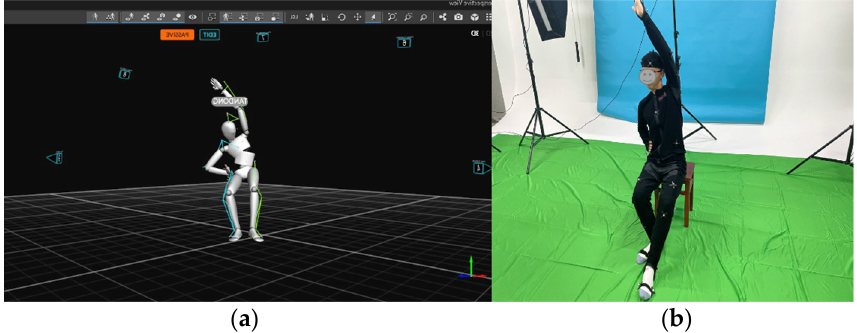
Figure 4. ( a ) The demonstrator wore a marked suit and demonstrated standard Yapa-PBGA gymnastics, and ( b ) his posture and movement were recorded with Opti-Track Motive.